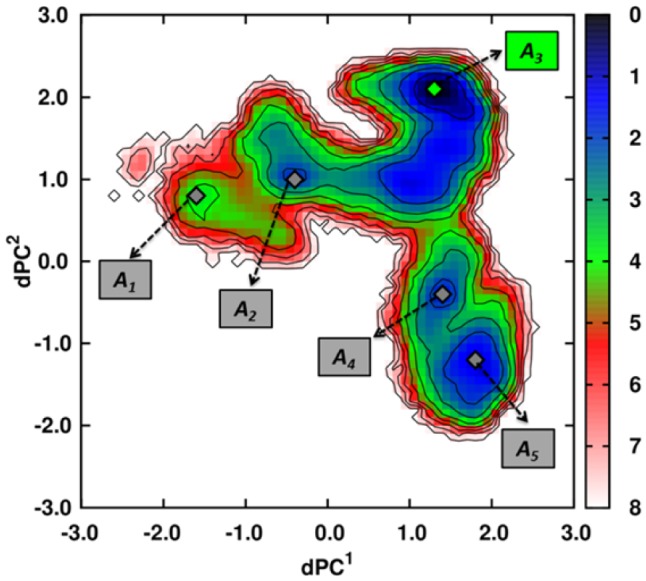
Dihedral principal component analysis applied to MD simulations of ATP-bound DnaK.FES computed for the MD run ATP1. Minima are shown with gray (green for the most probable one) diamonds and the isolines (black lines) are drawn every kBT unit. The color scale for the free-energy is in kBT units.